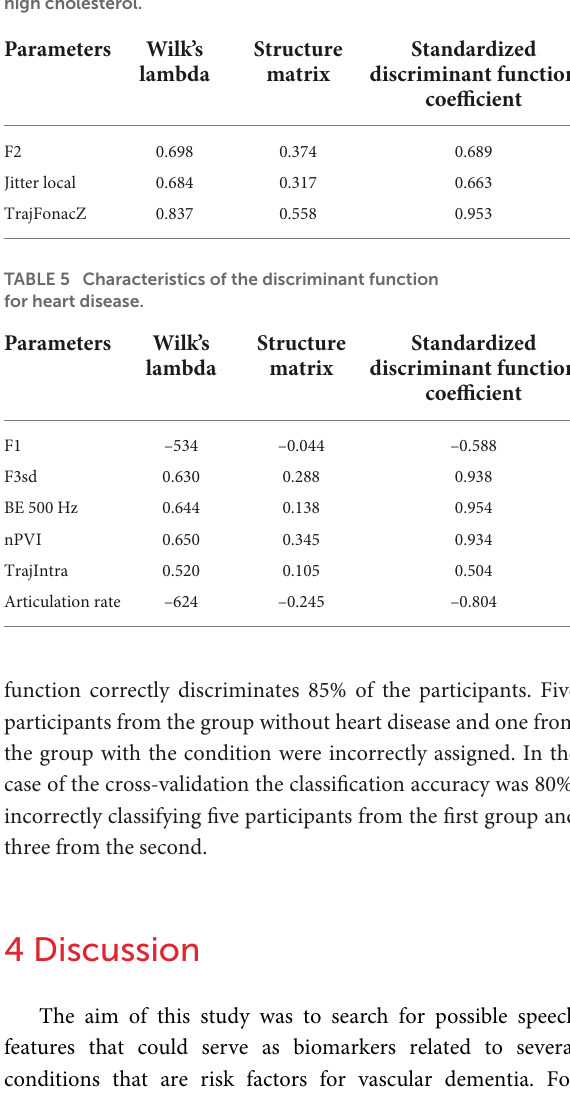
TABLE 4 Characteristics of the discriminant function for high cholesterol.